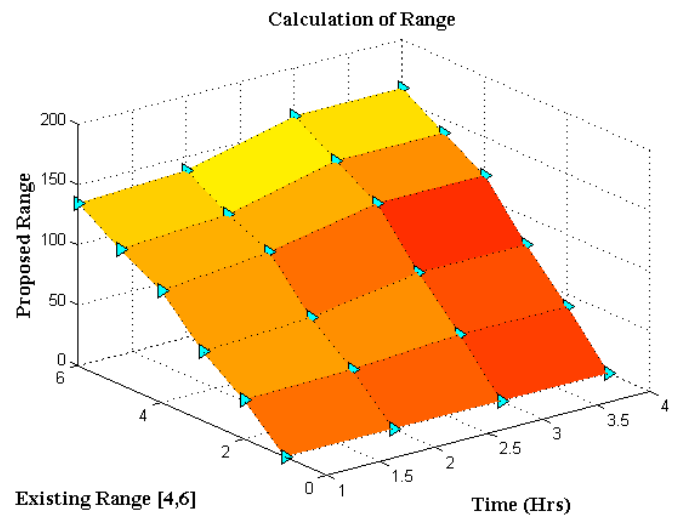
Figure 5. Drifting ranges for different interval.